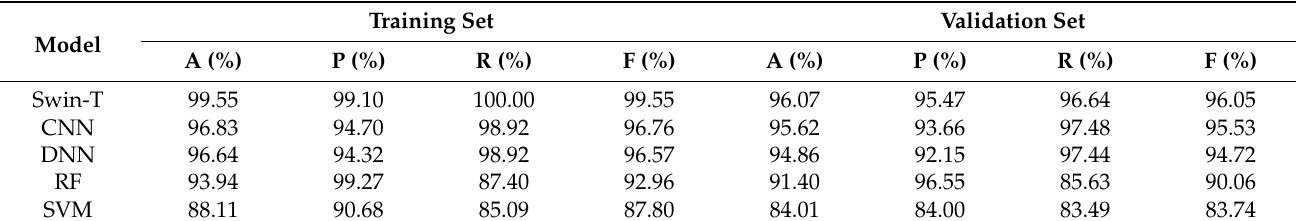
Table 4. Validation results of the models using indices.